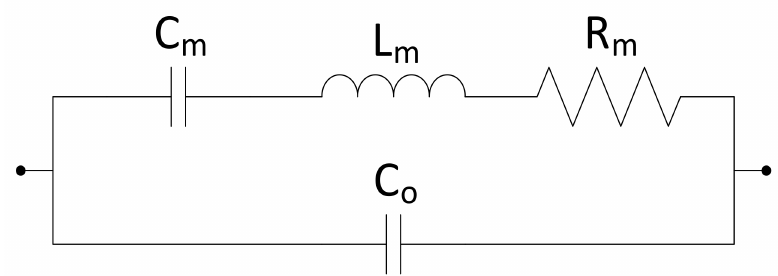
Figure 3. Butterworth-Van Dyke electrical model of a piezoelectric sensor.